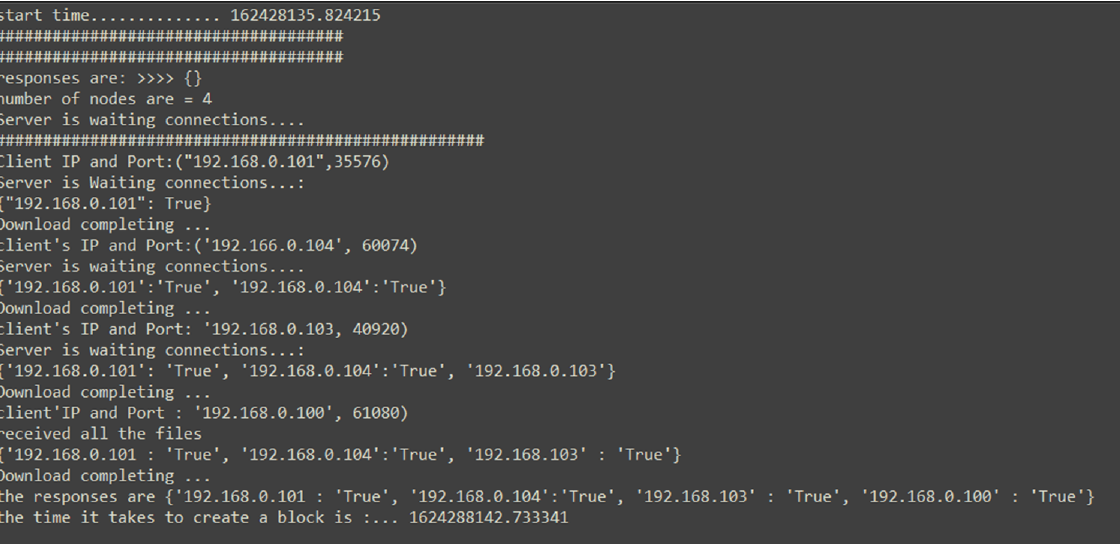
Figure 21. Responses and voting system on block creator’s side.